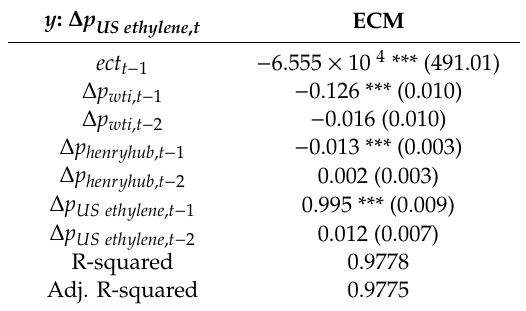
Table 5. Estimated results of error correction model (ECM) including time-varying cointegration